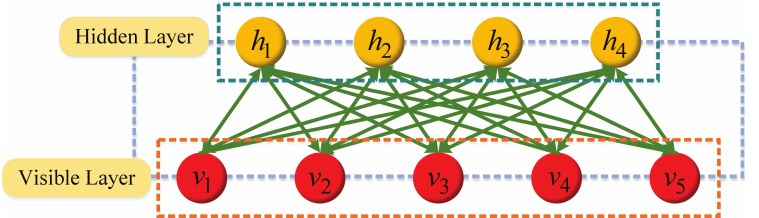
Figure 1. The network structure of